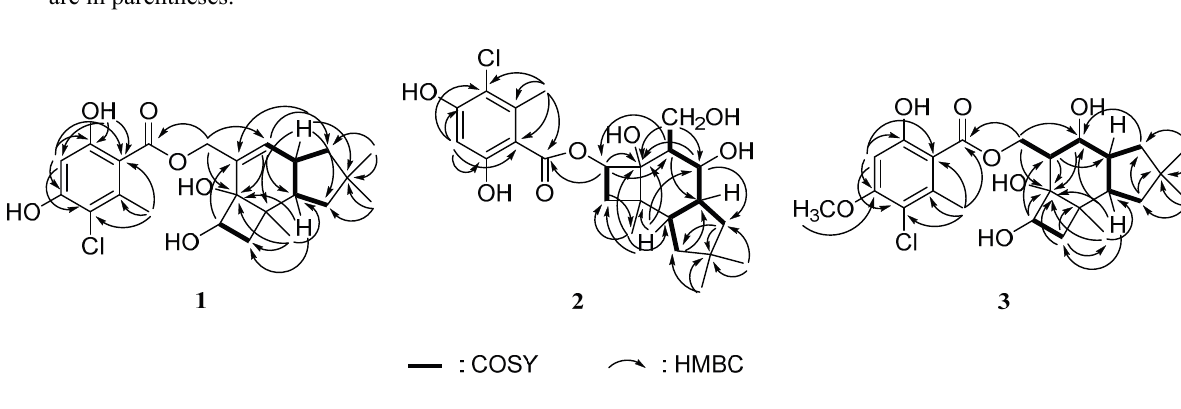
Figure 2. COSY and selected HMBC correlations of 1 – 3